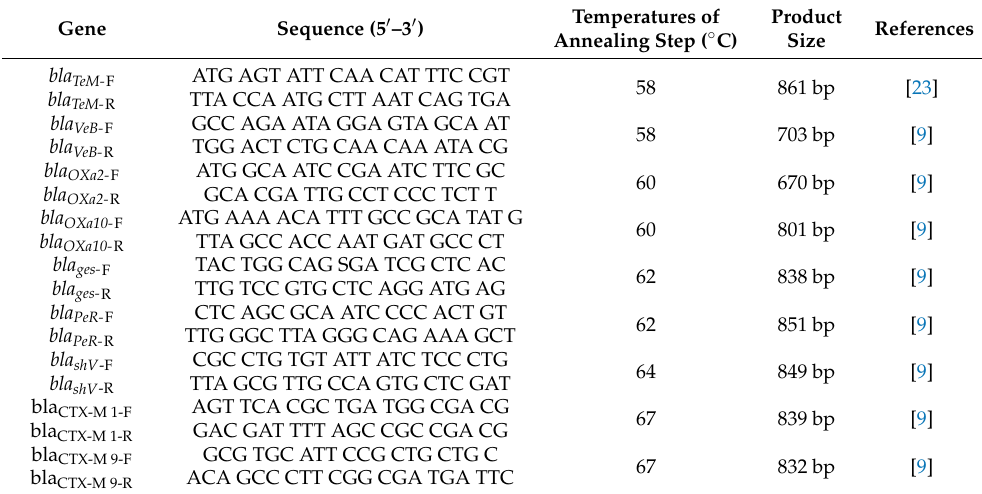
Table 1. Specific primers for ESBL genes